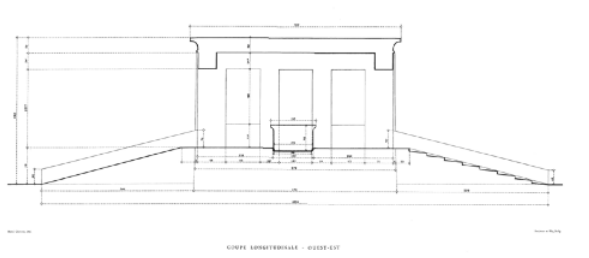
Figure 4 . Longitudinal section of the White Chapel.